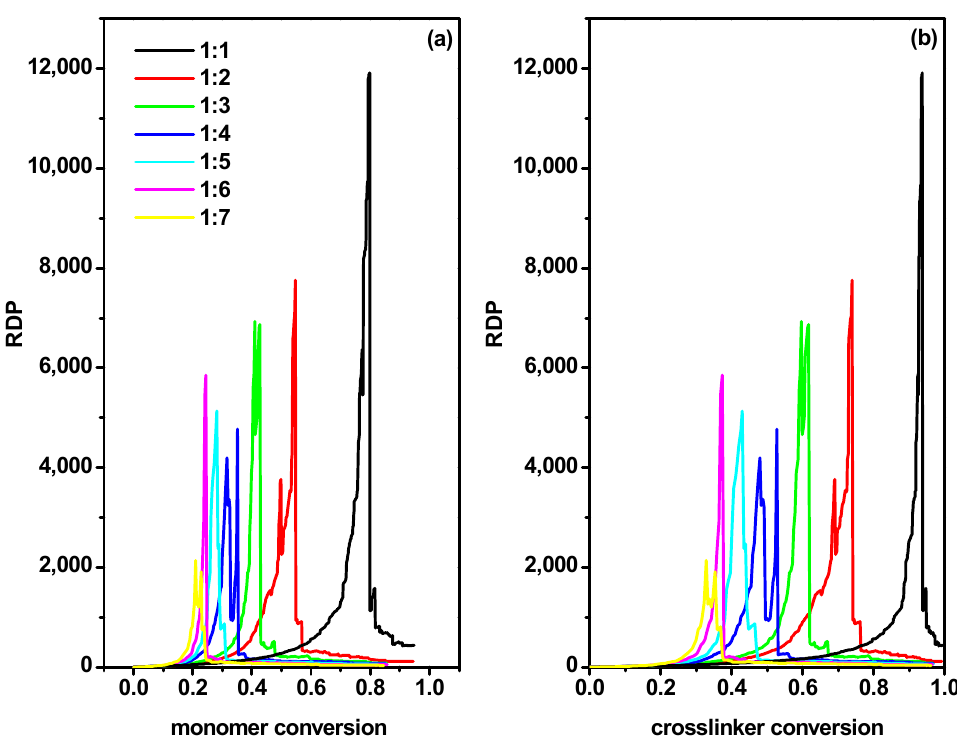
Figure 5. The reduced degree of polymerization as a function of monomer conversion ( a ) and the cross-linker conversion ( b ) for the distance between walls d = 50 and grafting density σ = 0.3. The values of the ratios [Ini]/[X] are given in the inset.